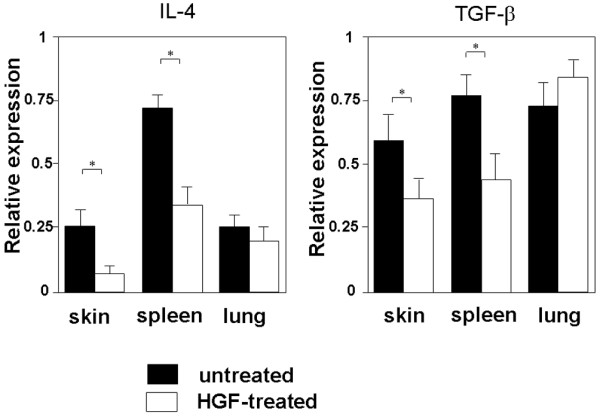
Effect of HGF on IL-4 and TGF-β1 mRNA expression in tight-skin mice. Total RNA was isolated from the skin, spleen, and lung, and IL-4 and TGF-β1 mRNA expression was analyzed by RT-PCR assay. Data represent the mean ± standard deviation from five mice. *p < 0.05. HGF, hepatocyte growth factor; IL, interleukin; TGF, tumor growth factor.